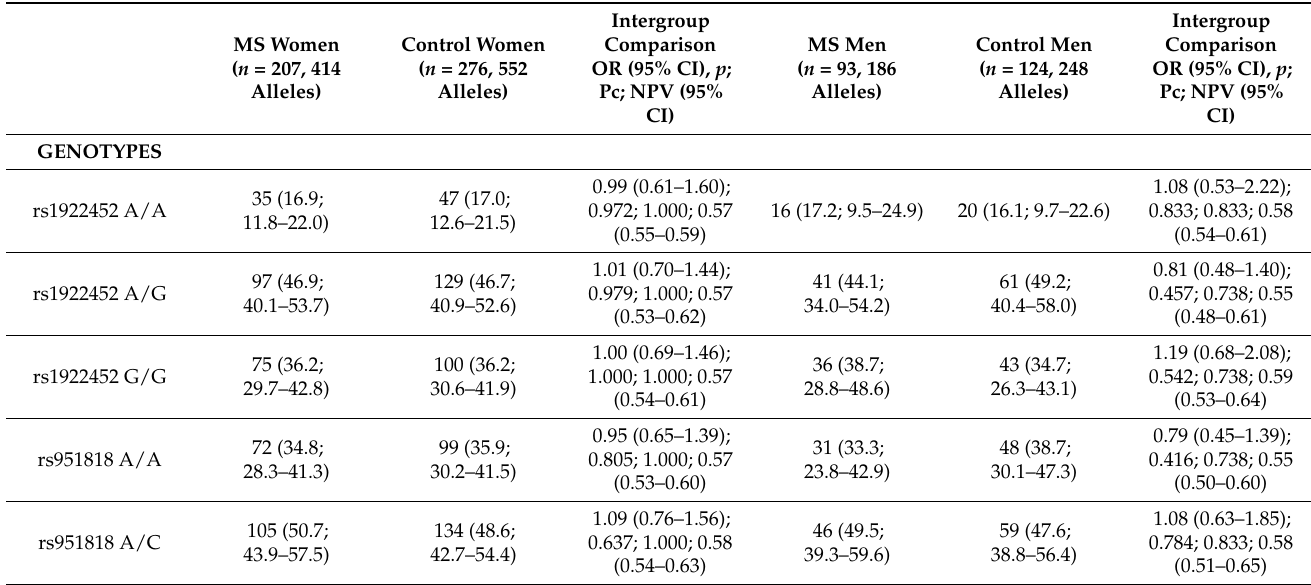
Table 2. Genotypes and allelic variants of patients with MS and of healthy volunteers, distributed by gender. The values in each cell represent the number (percentage; 95% confidence intervals). NPV: negative predictive